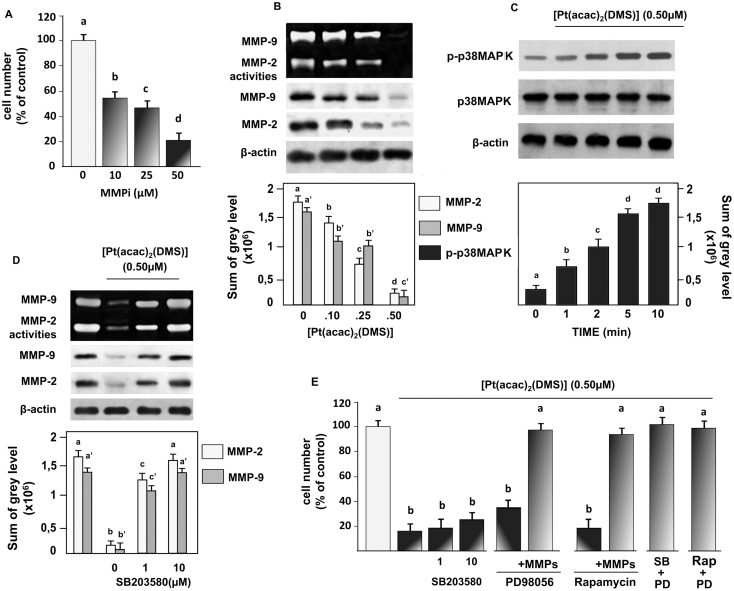
[Pt(acac)2(DMS)] inhibition of SH-SY5Y cell invasion is mediated by MMP-2 and MMP-9.(A) SH-SY5Y cells were treated or not with crescent concentrations of MMPs inhibitor (MMPi) and cell invasion was measured using the transwell invasion assay system, after 24 h. The data are means ± SD of four different experiments and are presented as per cent of control. (B) Cells were treated or not with increasing concentrations of [Pt(acac)2(DMS)] for 24 h; conditioned media and cell lysates were subjected to gelatin zymography and Western blot analysis with anti-MMP-2 and anti-MMP-9 antibodies, respectively. (C) SH-SY5Y cells were incubated with 0.50 µM [Pt(acac)2(DMS)] for the indicated times and cell lysates were subjected to Western blot analysis with anti-unphosphorylated (p38MAPK) and -phosphorylated (p-p38MAPK) p38MAPK antibodies. (D) SH-SY5Y cells were preincubated with different concentration of SB203580 and then treated or not with [Pt(acac)2(DMS)] for 24 h. Conditioned media and cell lysates were subjected to gelatin zymography and Western blot analysis with anti-MMP-2 and anti-MMP-9 antibodies, respectively. For Western blotting, control loadings are shown by β-actin and representative immunoblots of four experiments are depicted; results from densitometry are expressed as mean ± SD (n = 4) of sum of the gray level values. (E) SH-SY5Y cells were preincubated with 0.50 µM [Pt(acac)2(DMS)] in absence or in presence of SB203580 (SB), PD98056 (PD), rapamycin (Rap), alone or in combination, and of human MMP-2 and MMP-9 active proteins (MMPs), in combination to PD98056 or rapamycin. Cell invasion was measured using the transwell invasion assay system. The data are means ± SD of four different experiments and are presented as per cent of control. The data are means ± S.D. obtained from 4 different experiments. (A–E) P<0.0001 by one-way ANOVA (n = 4); values with shared letters are not significantly different according to Bonferroni/Dunn post hoc tests.